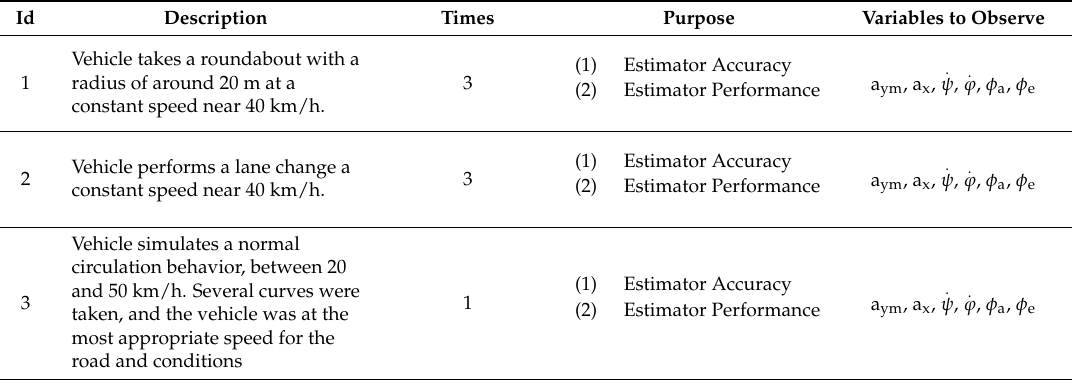
Table 2. Experiments proposed.